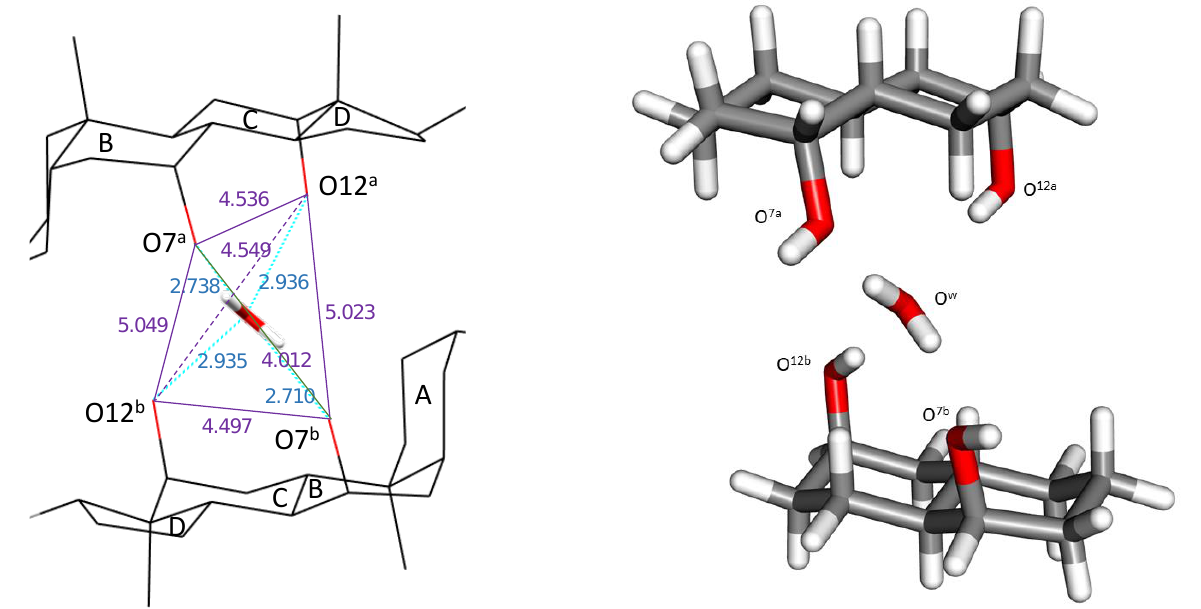
Figure 2. Left : Oxygen – Oxygen distances (lines and data in amethyst color) of the tetrahedron formed by the O 7 -H and O 12 -H hydroxy atoms of the two steroid residues encapsulating a water molecule located at their centroid [8]. The four hydrogen bonds are indicated with blue lines, as are the hydrogen bond distance values (O w -H ... O 7 and O 12 -H ... O w ). All data in Å . Right : Simplified sys-